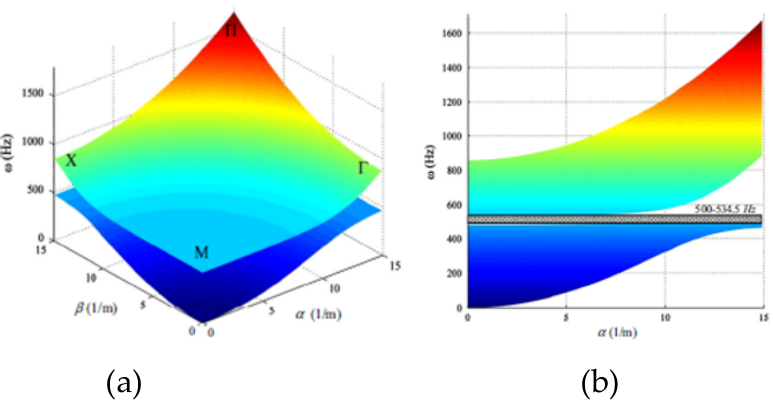
Figure 2. Dispersion surfaces and band gap of the above metamaterial: ( a ) dispersion surfaces; ( b ) stopband (gray rectangle) [7].